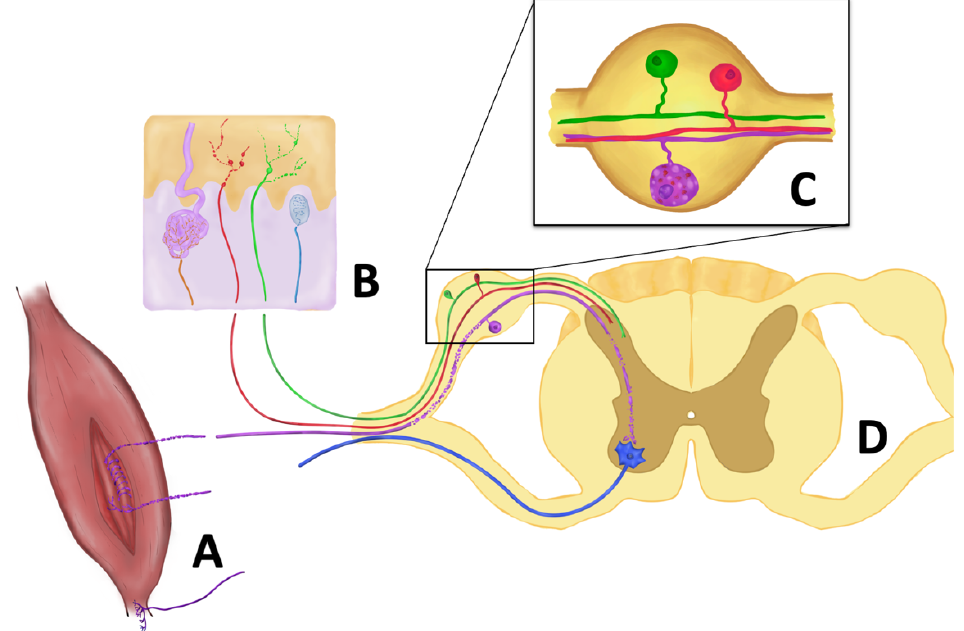
Figure 2. Main pathological changes in sensory afferents reported in ALS. ( A ) Degeneration of type Ia and II sensory fibers innervating muscle spindles, while type Ib fibers (Golgi tendon organ) are preserved. ( B ). Reduction of intraepidermal nerve fibers, terminals of both peptidergic (red) and non-peptidergic (green) axons, with focal swellings. Meissner corpuscle innervation (blue) is also impaired, as well as sympathetic fibers innervating sweat glands (brown). ( C ) In the dorsal root ganglion, neuronal bodies are preserved, although vacuolization and accumulation of misfolded SOD1 protein are seen in proprioceptive neurons (purple). ( D ) In the dorsal root, larger axons show Wallerian degeneration. In addition, proprioceptive synapses in the anterior horn are reduced in certain animal models (SOD1 G93A mouse) but preserved in others (TDP43 A315T mouse).